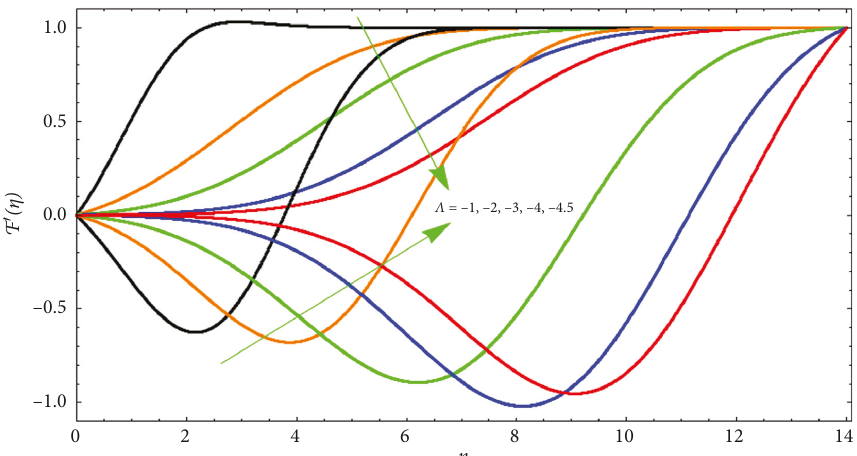
Figure 3: Dissimilarity of F ′ ( η ) being some different values of blowing Λ parameter for two solutions AFS and RFS.